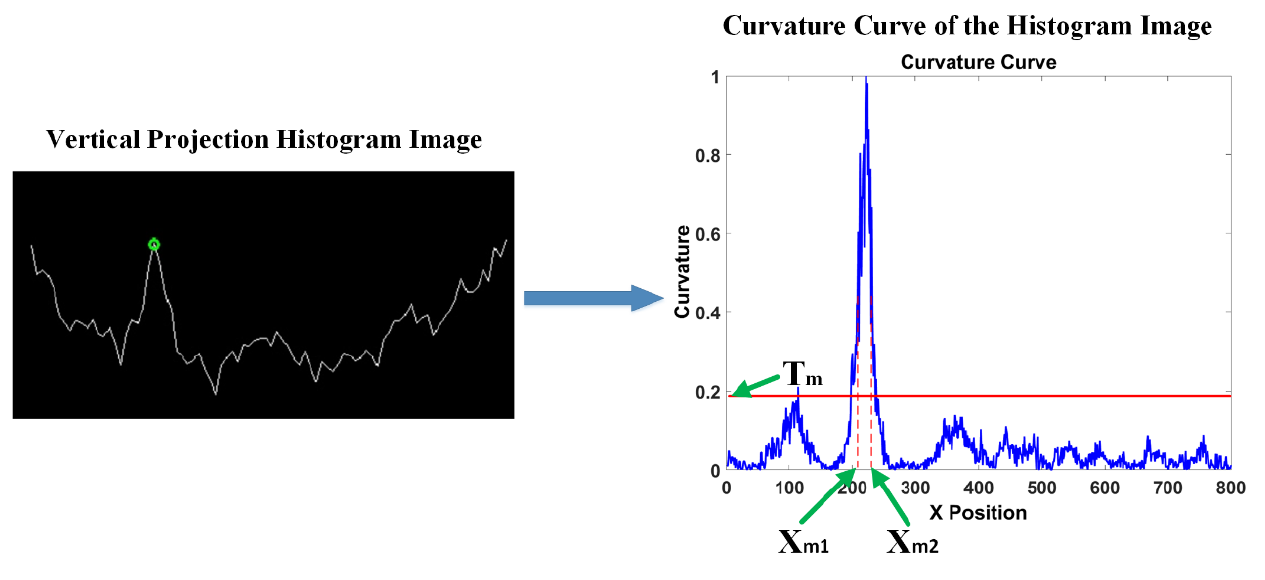
Figure 8. The result of cubic Bezier curve fitting. The green circle in the vertical projection histogram image represents the local peak detected by the proposed method.